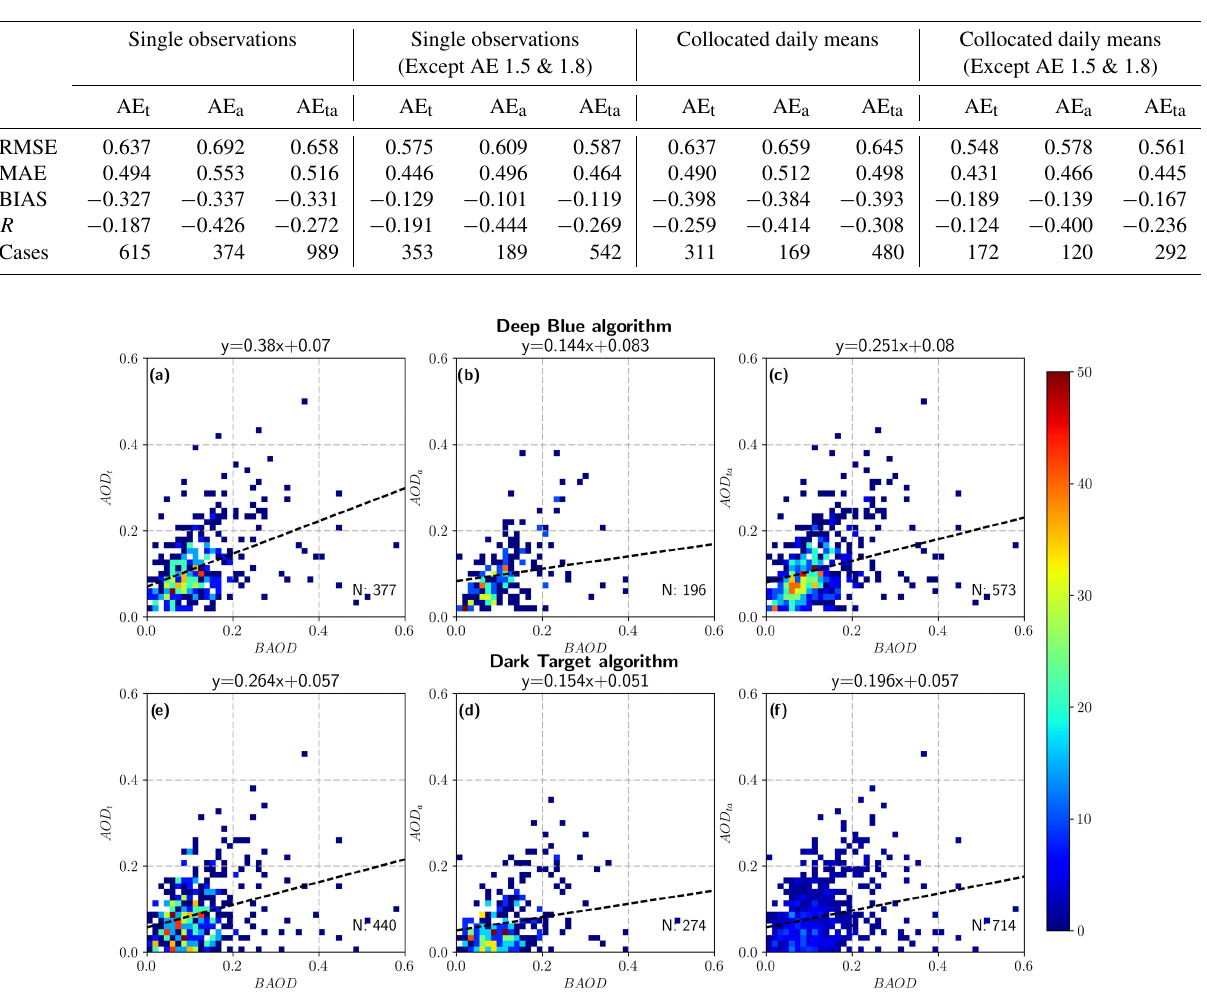
Figure 6. Single observations density scatter plots of the coincident BAOD observations from the broadband pyrheliometer and Terra and Aqua MODIS instruments for DB and DT algorithms: panels (a) to (c) show BAOD vs. AOD t and AOD a and AOD ta for the DB algorithm; (d) to (f) show the same for the DT algorithm. The data density is represented by the colour scale, showing the number of data points located in a particular area of the plot. Linear regression line is shown by the black discontinuous line and the corresponding equation. The number of data points appear in the right